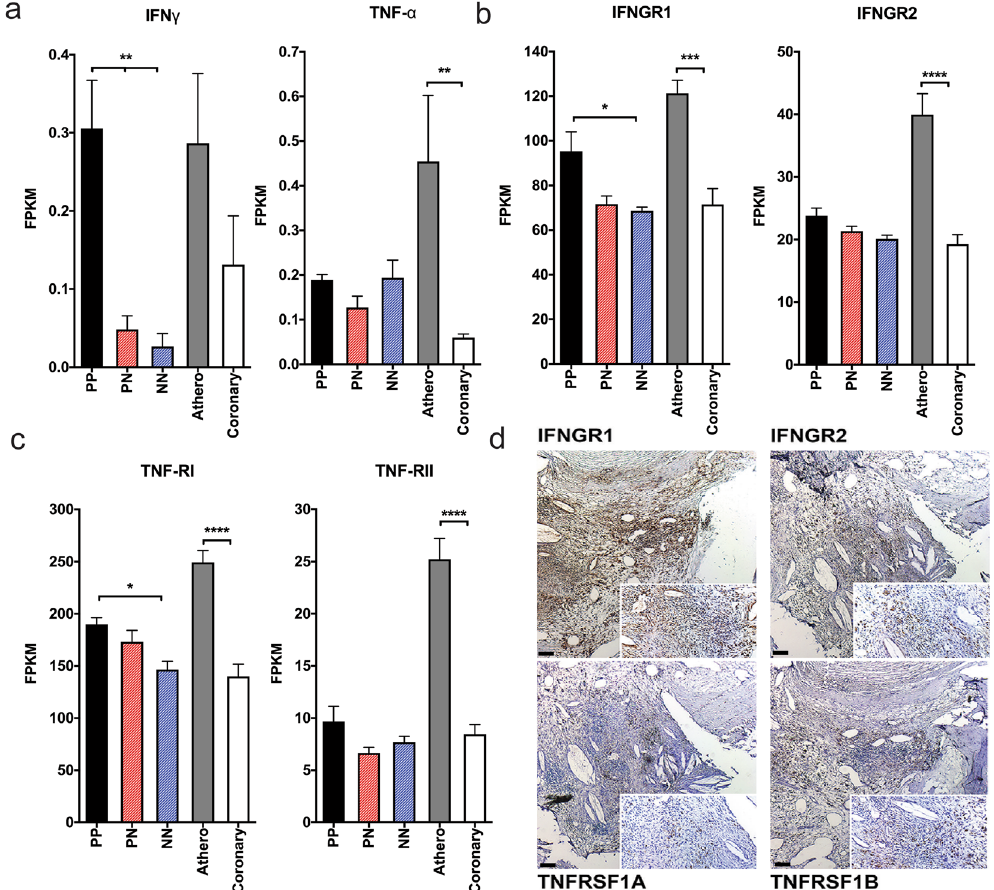
Figure 2. TNF and IFN- γ receptors have increased expression in atherosclerosis compared to psoriasis. ( a , b , c ) RNAseq revealed mRNA expression of the IFN- γ is elevated in psoriasis and atherosclerotic lesions, however the IFN- γ receptors (IFNGR1, IFNGR2) TNF- α and the TNF- α receptors (TNF-RI and TNF-RII) are increased in atherosclerosis lesions compared to psoriasis, (data obtained from RNA seq and values shown as FPKM (Fragments per Kilobase of transcripts per Million mapped reads). (n = 6 lesional (PP), non-lesional (PN) and healthy (NN), n = 4 atherosclerotic (athero), n = 4 healthy vascular tissue (coronary), ** p < 0.01, *** p <